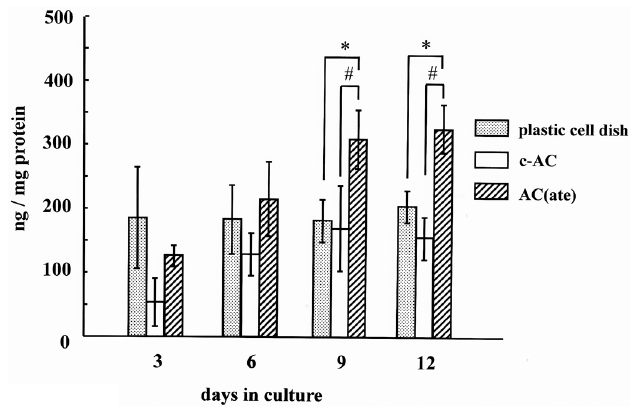
Figure 6. Time course of the amount of osteocalcin produced by MC3T3-E1 cells in cultures with each type of specimen. Results are shown as the mean ± standard deviation ( n = 5). * and # indicate a significant difference as compared to the plastic cell well and c-AC, respectively (Student’s t -test: p < 0.05).